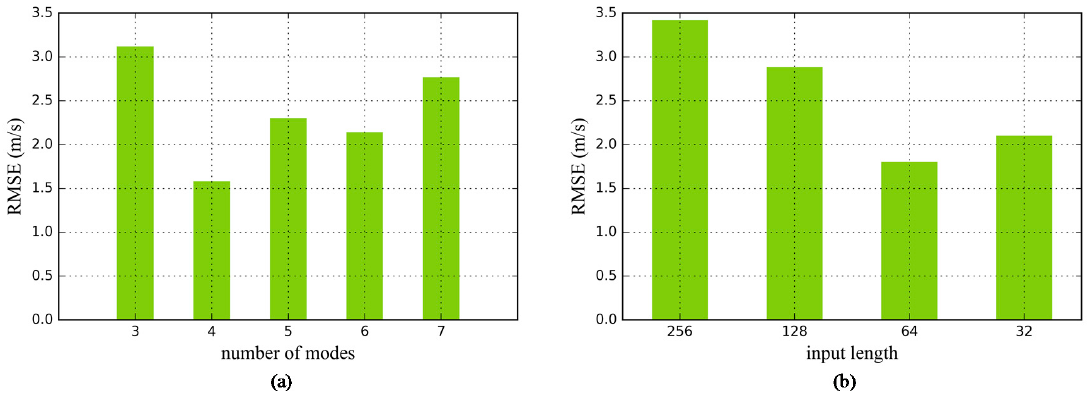
Figure 5. Comparison of different model parameters: ( a ) number of modes, ( b ) input length.